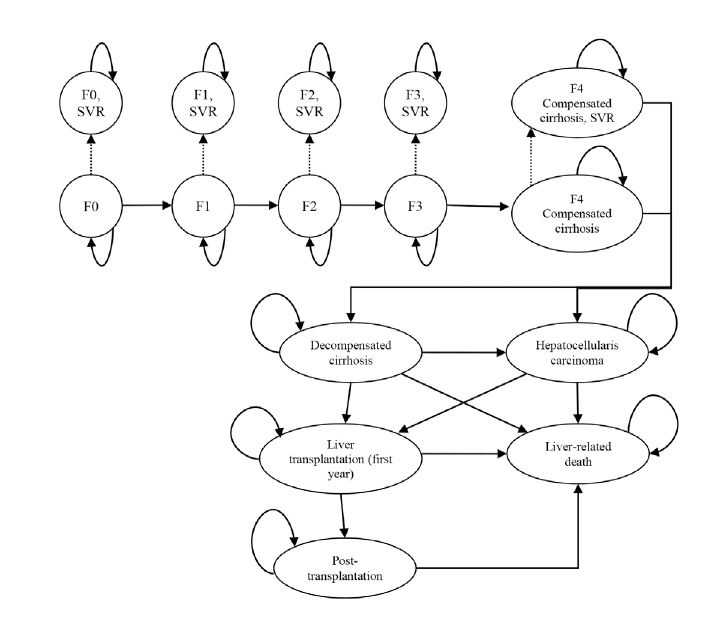
Figure 1. State-transition Diagram for the Markov Model